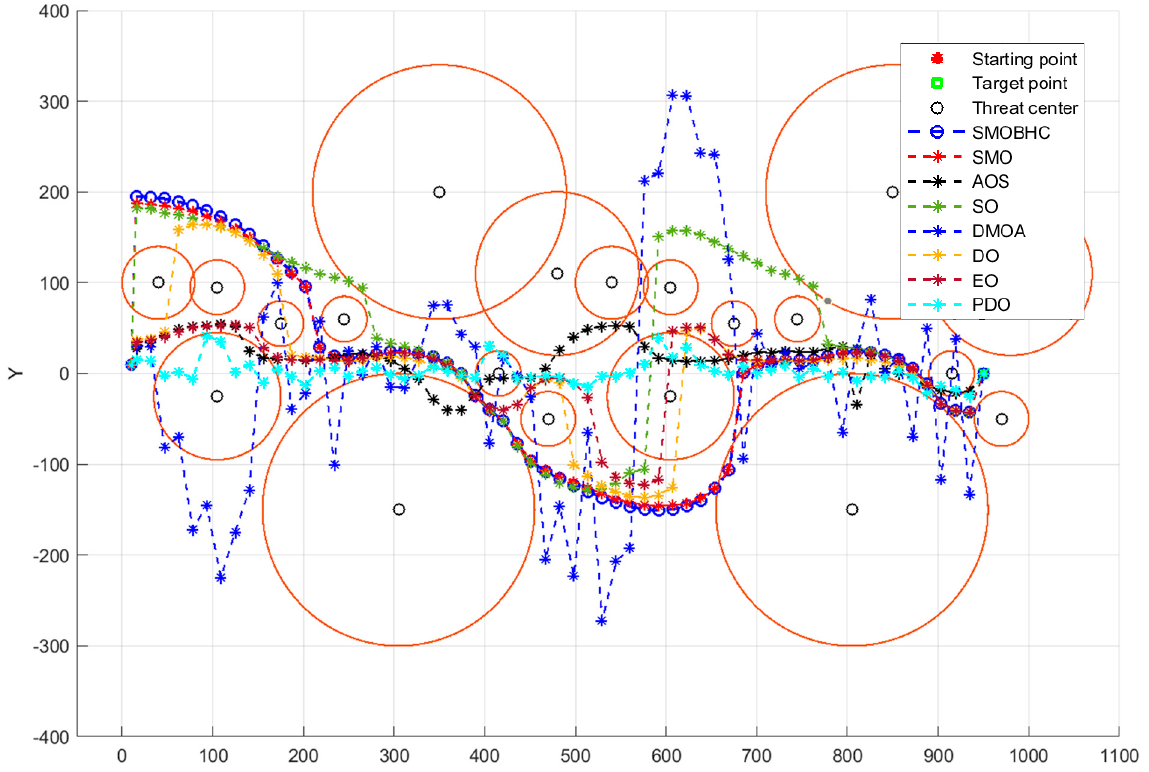
Figure 22. Comparison between SMOBHC and other seven algorithms for battlefield 3 with 𝐷 = 60 .